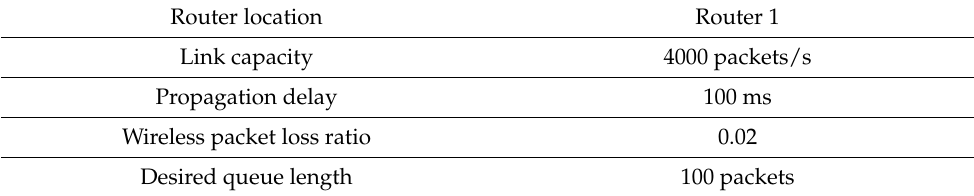
Table 3. Default network parameters.